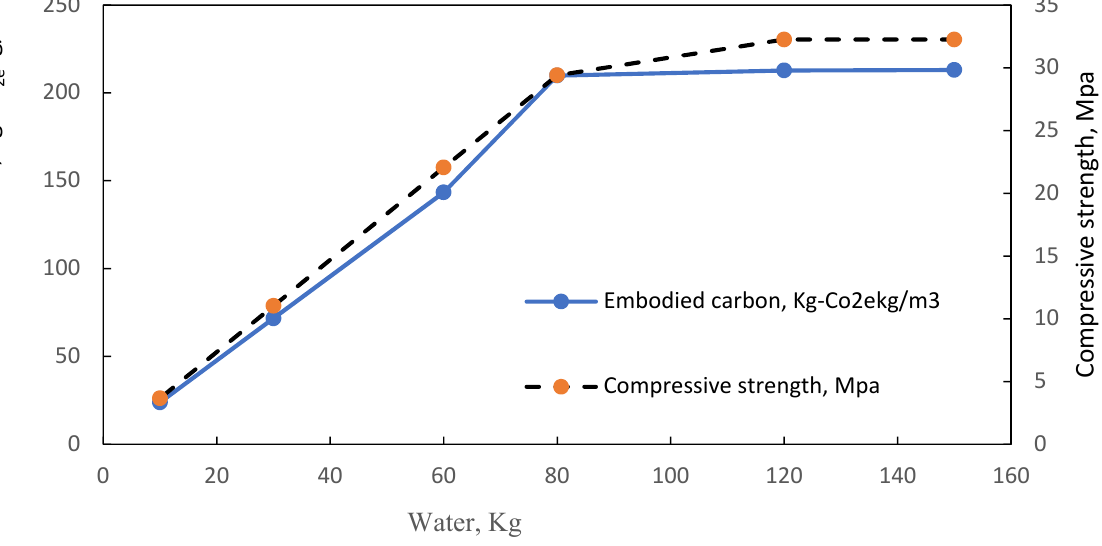
Figure 11. LCC at optimal water content of 80 litres per m 3 of concrete [22].